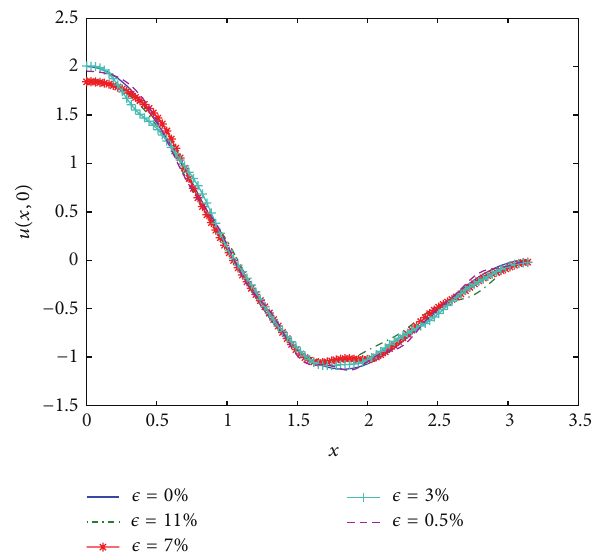
Figure 5: Exact solution 𝑢(𝑥, 0) and numerical solution for 𝜖 ∈ {11 % , 7 % , 3 % , 0.5 % } with the final time 𝑇 = 0.1 and 𝑚 = 59 , = 1𝑒 − 10 . 𝑁 = 55 , and 𝑡 0